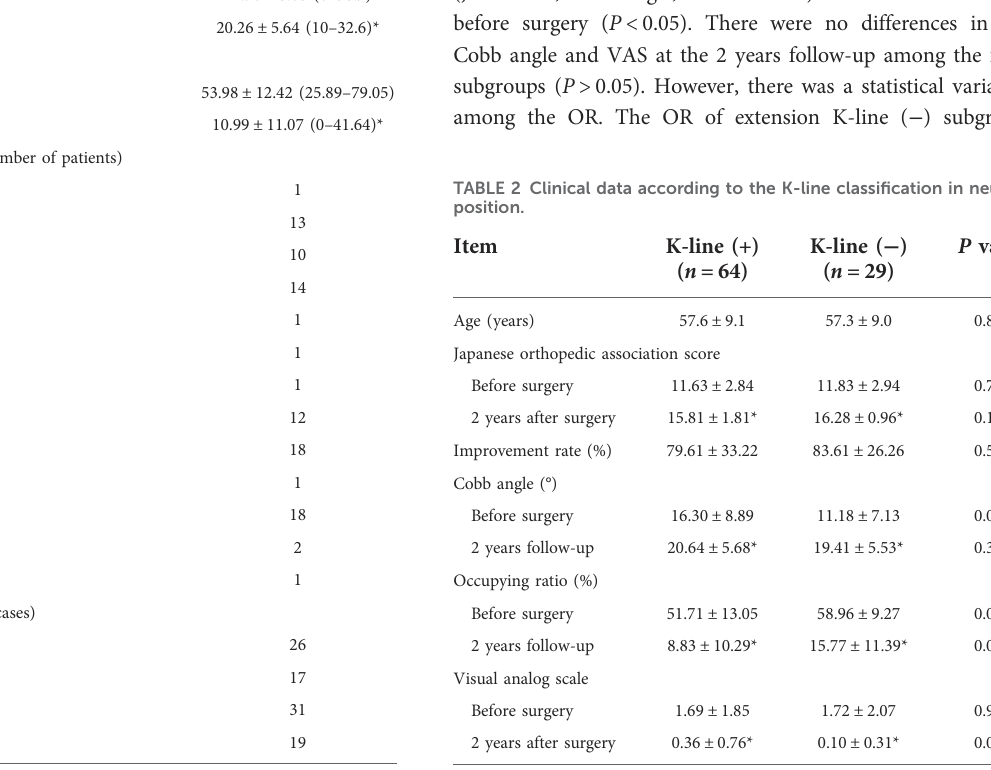
Values are mean±standard error. *Statistically different from the data before